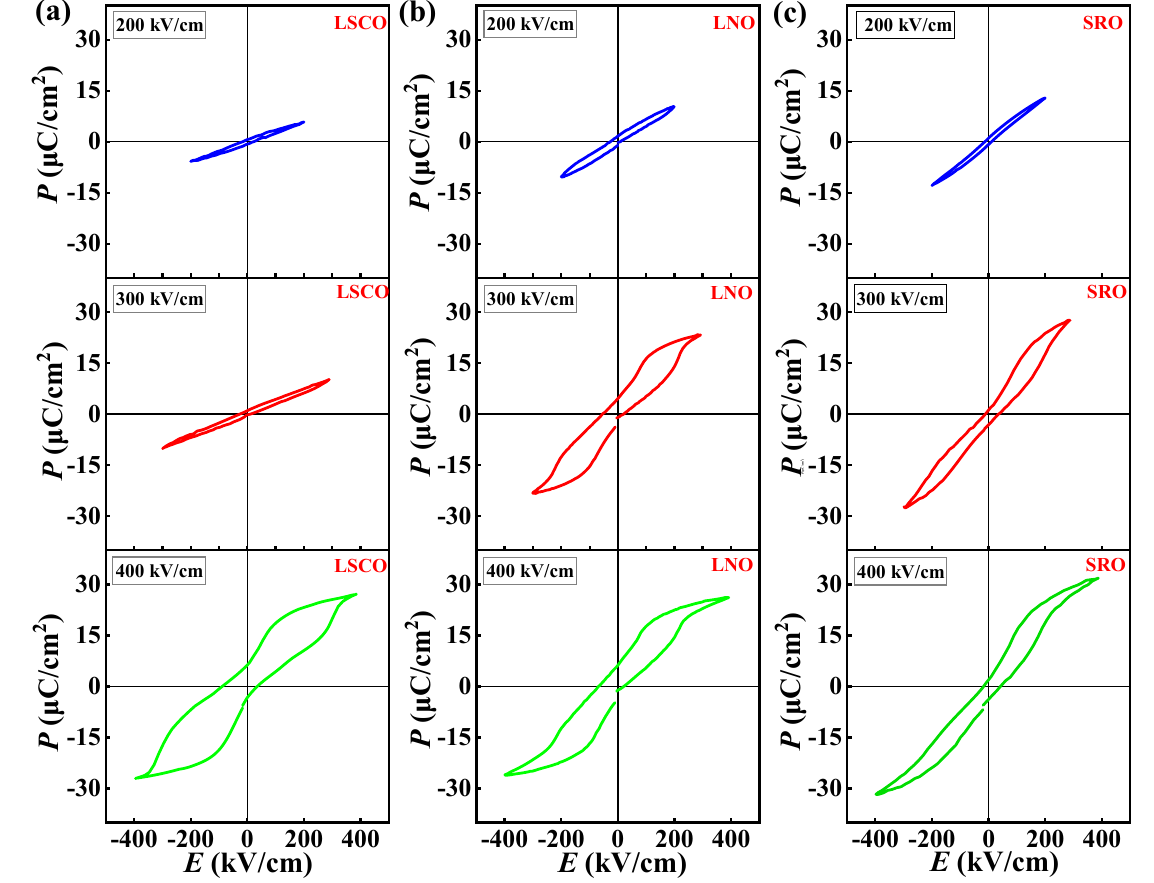
Figure 5. P ‐ E loops of ANO films grown on LSCO ( a ), LNO ( b ) and SRO ( c ) bottom electrodes under 200 kV/cm, 300 kV/cm and 400 kV/cm. Table 2. Properties of ANO films grown on LSCO, LNO and SRO bottom electrodes.